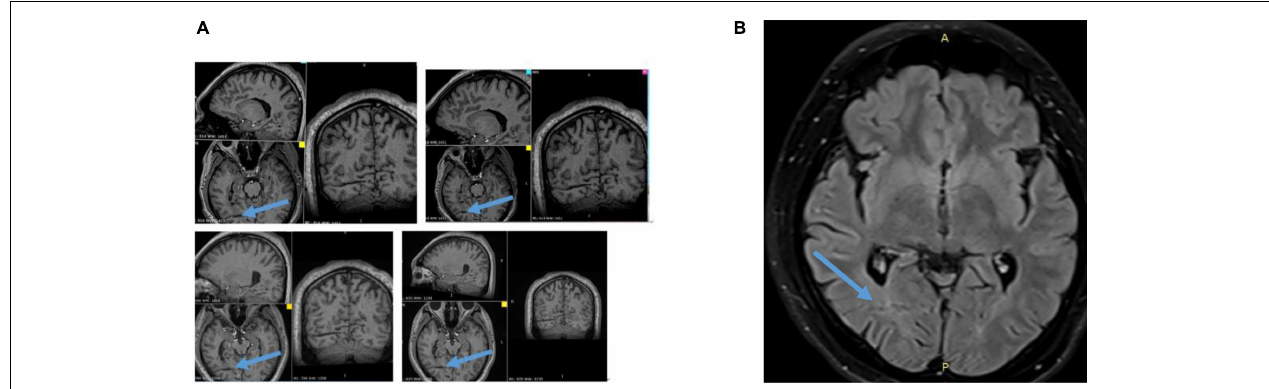
FIGURE 4 | (A) Follow-up for 58 months, 3D MRI showing a trace of RFTC at the post-GMNH every year from 2016 to 2019. (B) T2 Flair of MRI showing a trace of RFTC at the POST-GMNH and overlying cortex. Blue colored arrow showing a trace of RFTC.